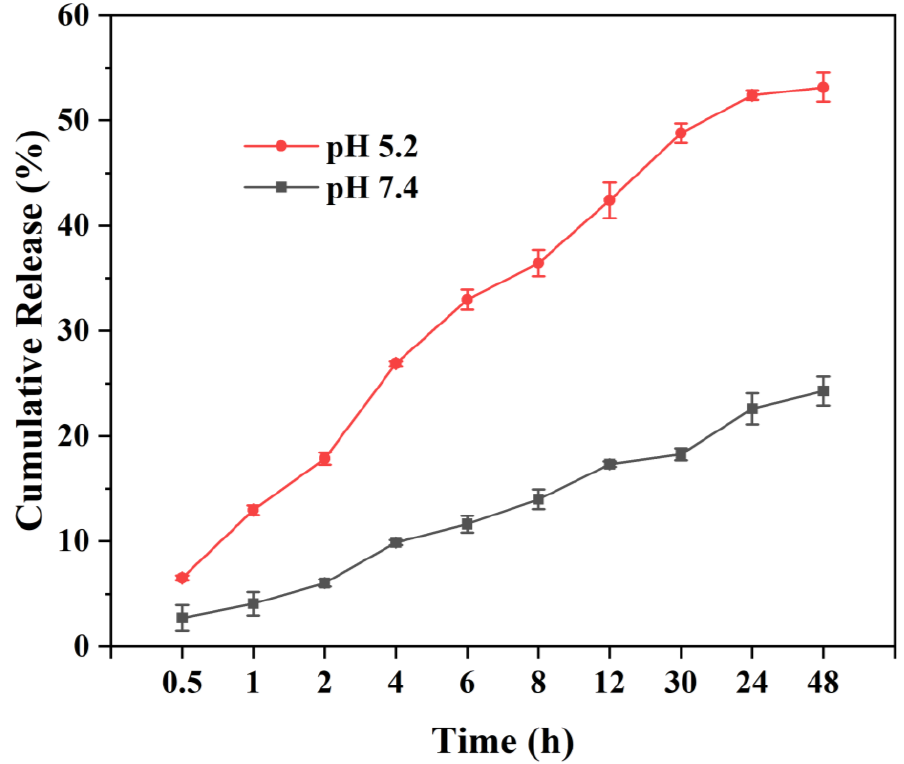
Figure 8. The ability of MPDA-Fe(III)-DOX-HA to release DOX in different pH environments.